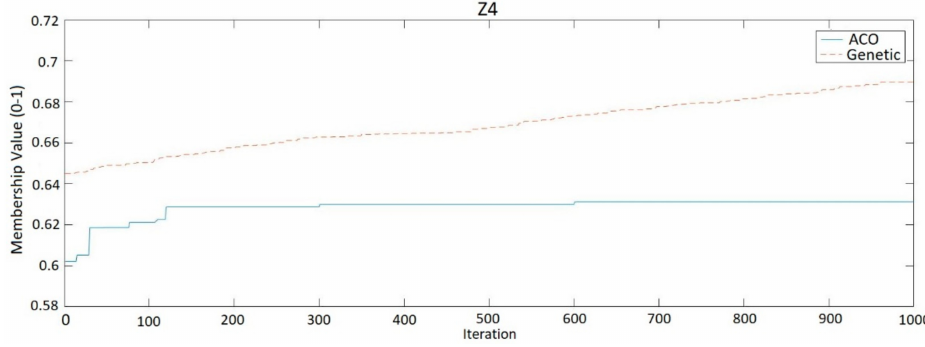
Figure 6. Maximization process of Z